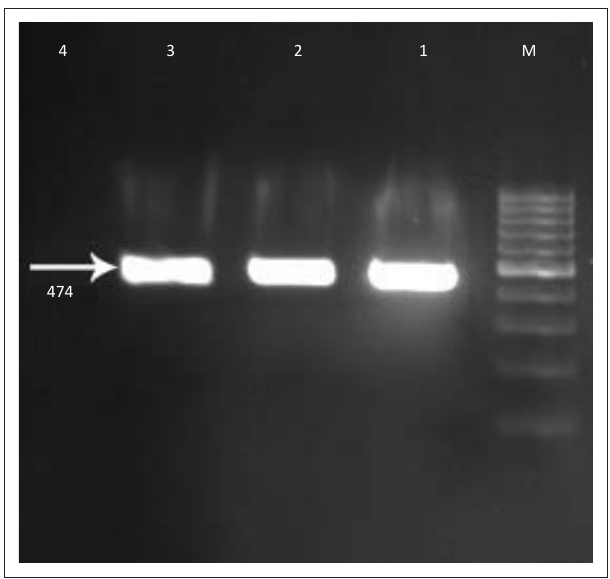
FIGURE 1: Detection of Leptospira deoxyribonucleic acid in kidney tissue of a cow by polymerase chain reaction-based LipL32